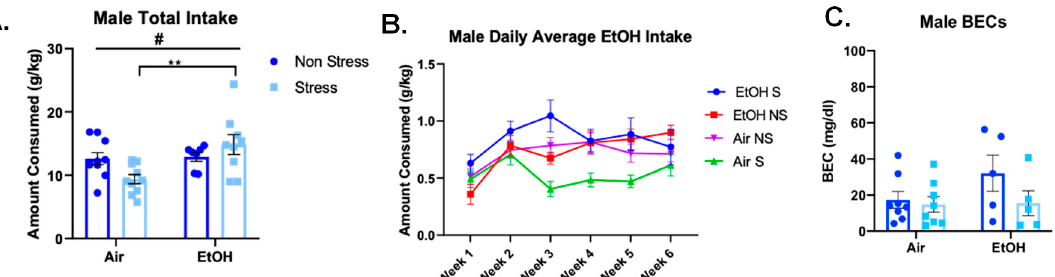
Figure 8. Male voluntary ethanol (10%) intake following FSS. ( A ) Cumulative intake across the eighteen sessions indicates a significant effect of ethanol exposure driven by the stressed groups. Ethanol ‐ exposed males drank significantly more than air ‐ exposed males, and stressed, ethanol ‐ exposed males consumed significantly more than stressed, air ‐ exposed males. Significant effect of ethanol denoted as # p < 0.05; interactions denoted as ** p < 0.01. ( B ) Daily intake averages per week indicates significant ethanol × stress × week interactions. ( C ) BECs at the end of the final drinking session.